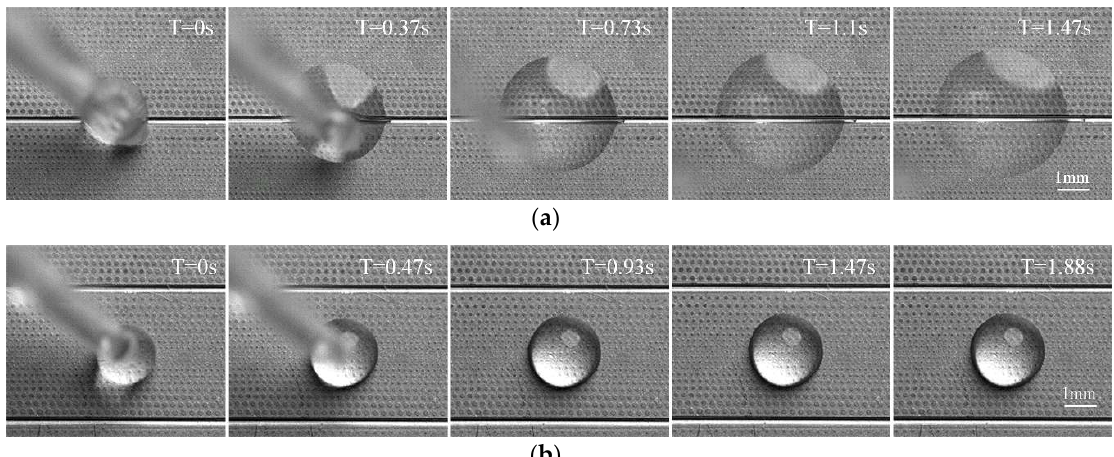
Figure 5. Silicone oil spreading morphology when added to different gradient regions on the functionalized surface: ( a ) Silicone oil spreading behavior when added to the region with low pillar density; ( b ) silicone oil spreading behavior when added to the region with high pillar density.